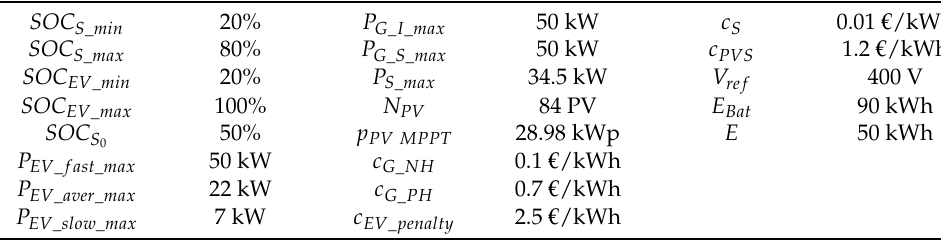
Table 1. Optimization and simulation parameter values.